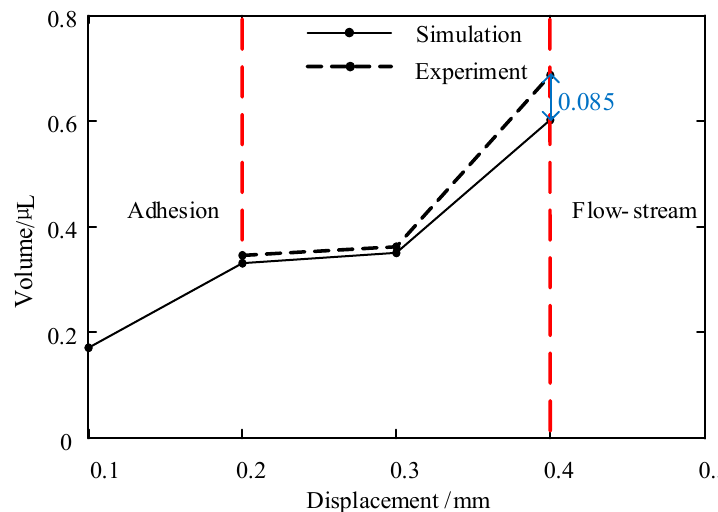
Figure 8. The influence of needle displacement on the volume of the droplet. Conditions: The nozzle diameter is 0.2 mm, the frequency is 20 Hz, the viscosity is 0.8 Pa·s, and the pressure is 0.6 MPa.